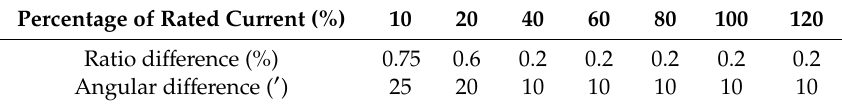
Table 4. 0.2 class national standard error of ratio difference and angular difference.